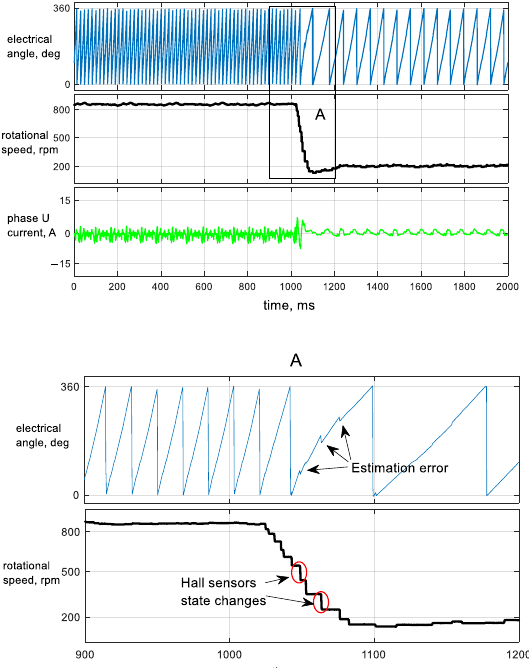
Figure 13. Waveform of the estimated value of the Θ M angle, the measured rotational speed and the motor phase U current for the closed-speed loop regulator system and changing the setpoint from 900 to 500 rpm for idle state.